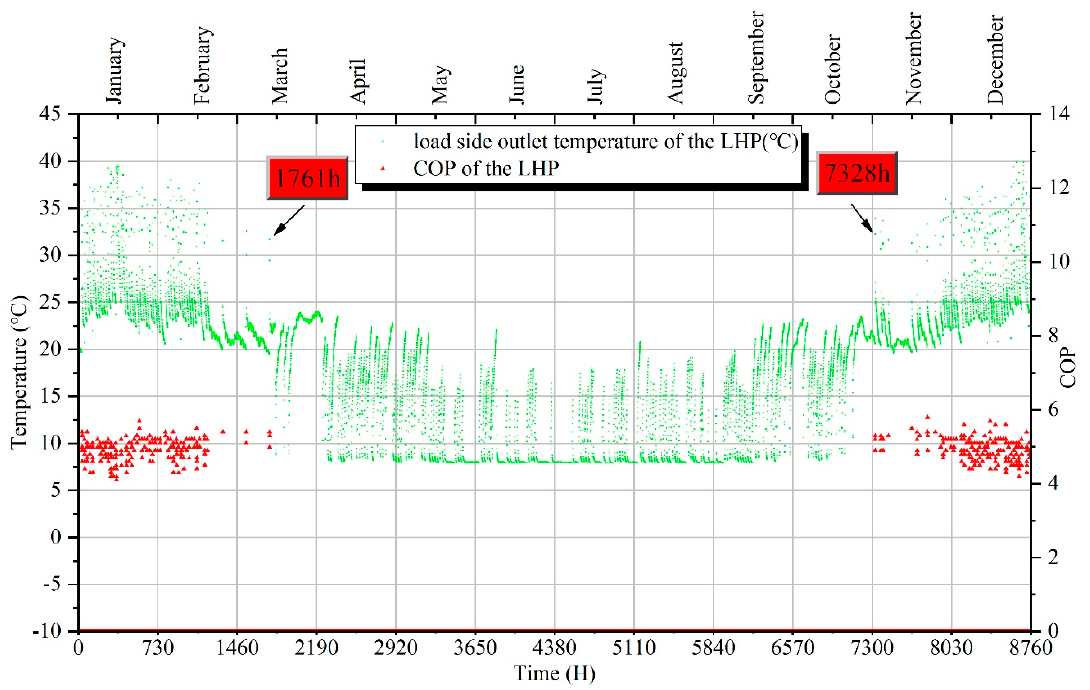
Figure 13. Coefficient of performance (COP) and load side outlet temperature of the LHP during a year.